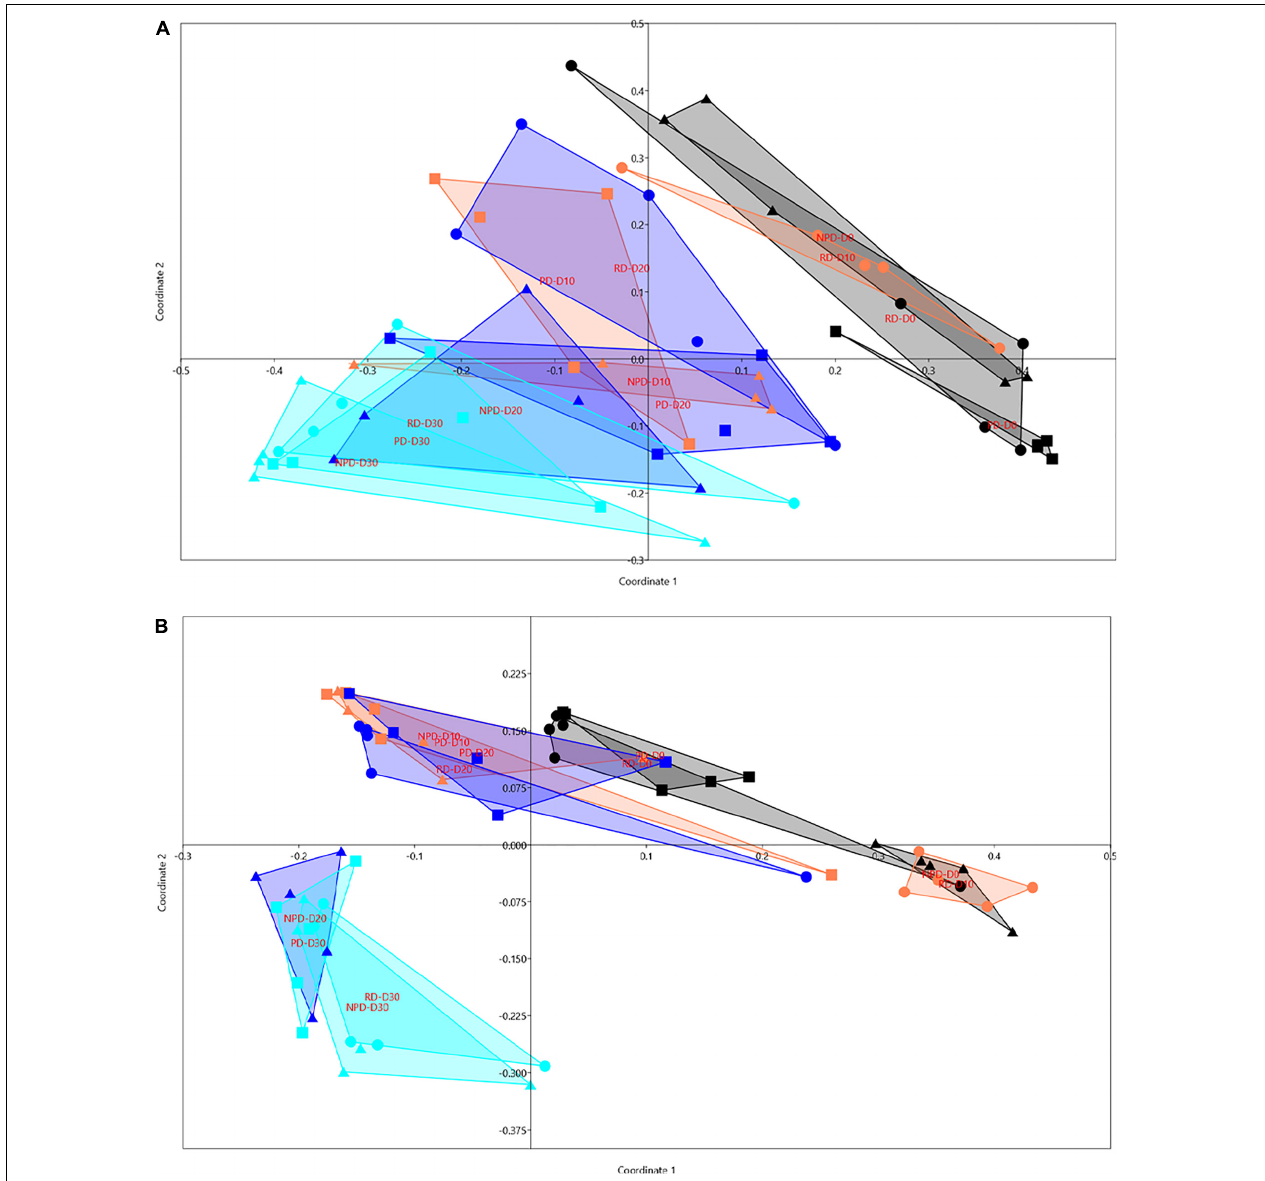
FIGURE 4 | Principal coordinate analysis plot based on (A) Bray Curtis index and (B) Jaccard dissimilarity showing the shift in gut bacterial community of rainbow trout with diet and time. Reference diet (0), preconditioned diet ( (cid:3) ), non-preconditioned diet ( (cid:49) ). Different colors represent day interval; days 0